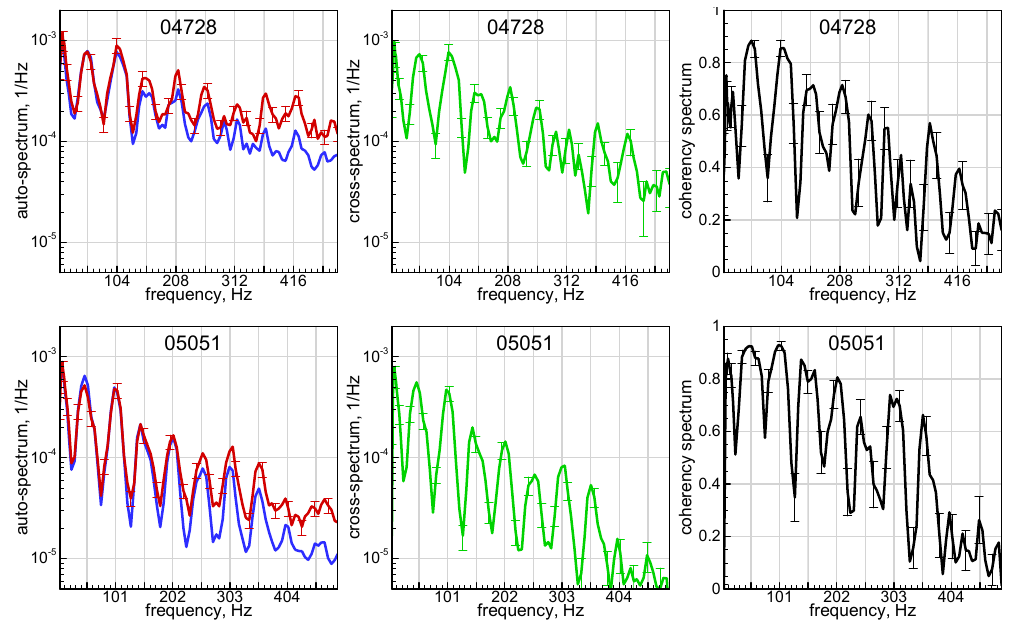
Fig. 2. Experimental scintillation spectra of α -Cru. Left panels: auto-spectra (line colours correspond to wavelengths of fast photometers), centre panels: moduli of cross-spectra, right panels: coherency spectra. Vertical grid hereafter shows the modulation periods. Error bars show rms uncertainty of spectra estimates (Bendat and Piersol, 1986) (rms uncertainties for red and blue auto-spectra are similar).